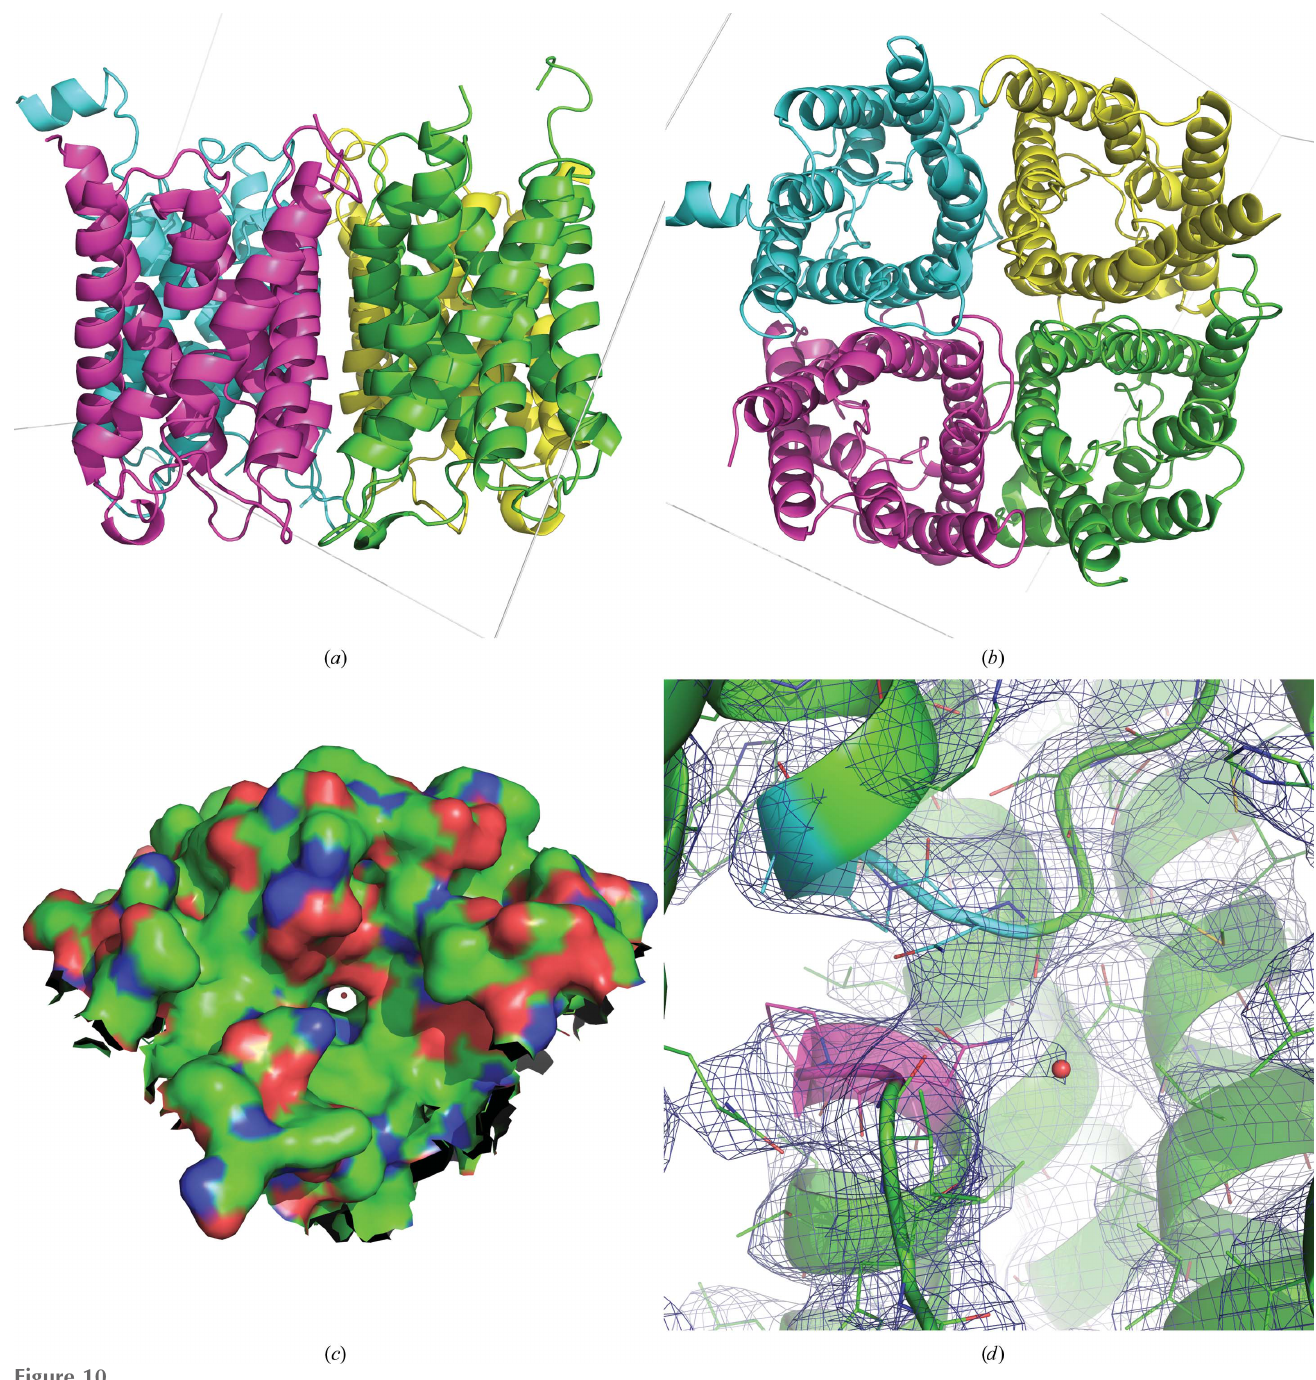
Figure 10 Structure of human aquaporin 2 (hAQP2) obtained by room-temperature SFX from crystals directly grown on Roadrunner II chips. Views are parallel to the membrane plane ( a ) and perpendicular to the membrane plane ( b ) in cartoon representation. hAQP2 forms a homotetramer, with each monomer consisting of six transmembrane helices and two half-helices forming a pseudo-transmembrane helix. Each monomer is shown in a different color for clarity. Gray lines indicate the unit cell axes. ( c ) Awater molecule (red sphere) is situated in the middle of the water channel of one monomer. The shown surface represents the solvent-excluded surface area viewed from the extracellular side. ( d ) The view perpendicular to the water channel shows that the water molecule is situated at a hydrogen-bond distance from the side chain of Asn68. This residue is part of the highly conserved dual NPA motif (pink and cyan) in the center of aquaporin channels that plays a central role in channel selectivity. The 2 mF o (cid:5) DF c electron density is shown at 0.8 (cid:5)